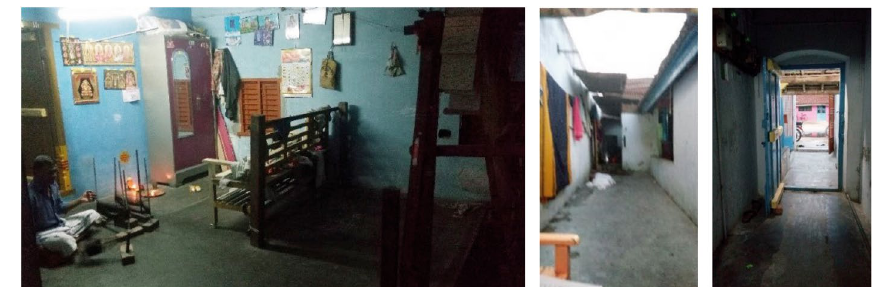
Fig. 21 Details of a joint family dwelling with a room accommodating the loom, the courtyard and the entrance (Source: the